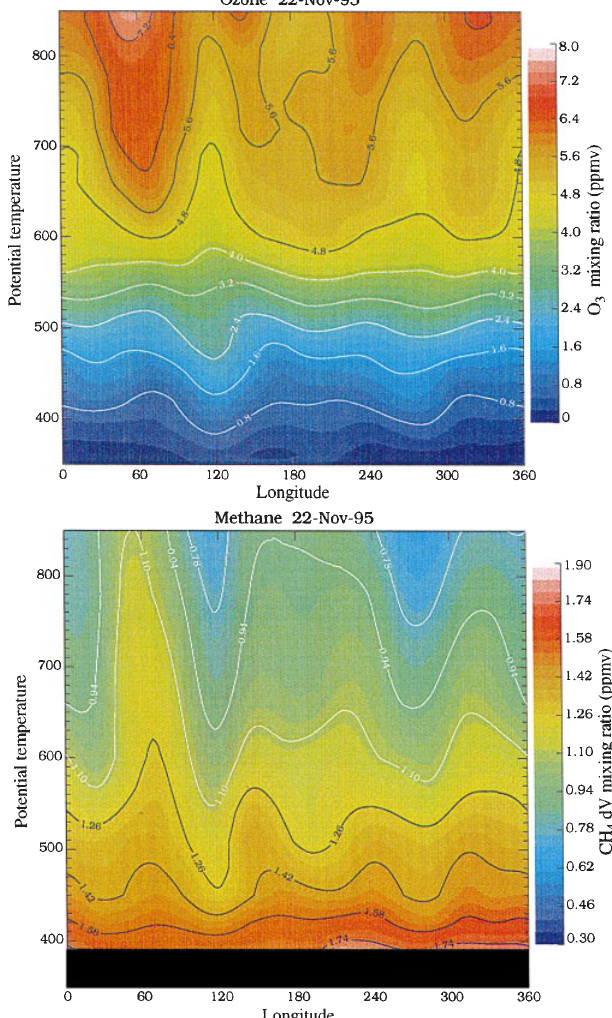
Fig. 2. Observations of the Halogen Occultation Experiment (HAL- OE) at sunset on November 22, 1995 (uarsday 1533), at 47 (cid:14) N. O 3 ( top panel ) and CH 4 ( bottom panel ) mixing ratios, measured by HALOE, are shown versus longitude and potential temperature (as a vertical coordinate). Vortex air is discernible over the whole altitude range at 118 (cid:14) E. The HALOE data were processed with software